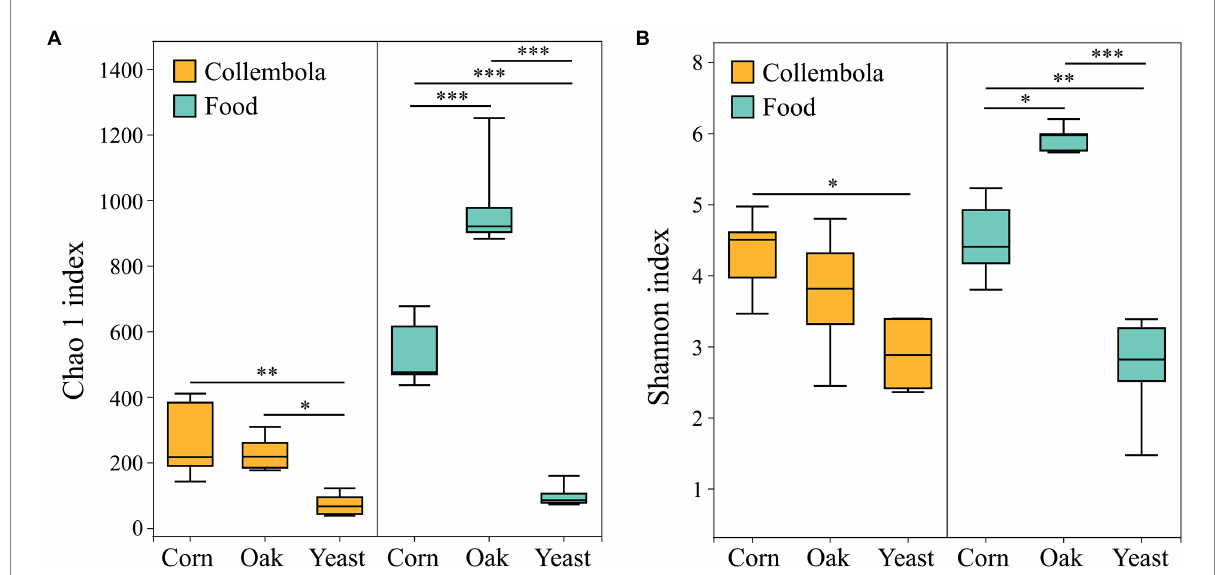
FIGURE 2 Box plot of the bacterial diversity of cold-adapted Collembola and food estimated by (A) Chao 1 richness index and (B) Shannon index. *** denotes p < 0.001; ** denotes p < 0.01; * denotes p < 0.05 based on Kruskal–Wallis